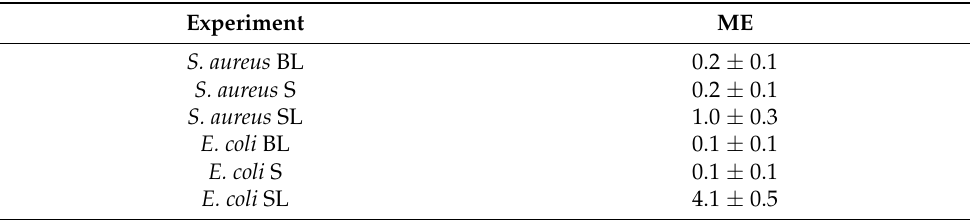
Table 2. ME values obtained with a PDMS sample containing GNS concentration at 2.7 × 10 − 6 mol Au/g of elastomer. Samples named BL and SL were irradiated with an 808 nm laser with irradiance of 264 mW/cm 2